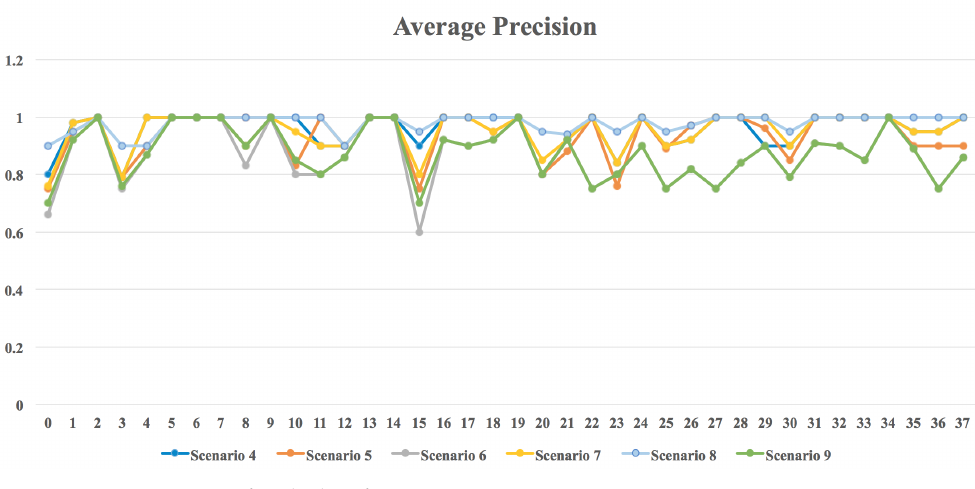
Figure 19. AP measure of each class for Scenarios 4 to 9.